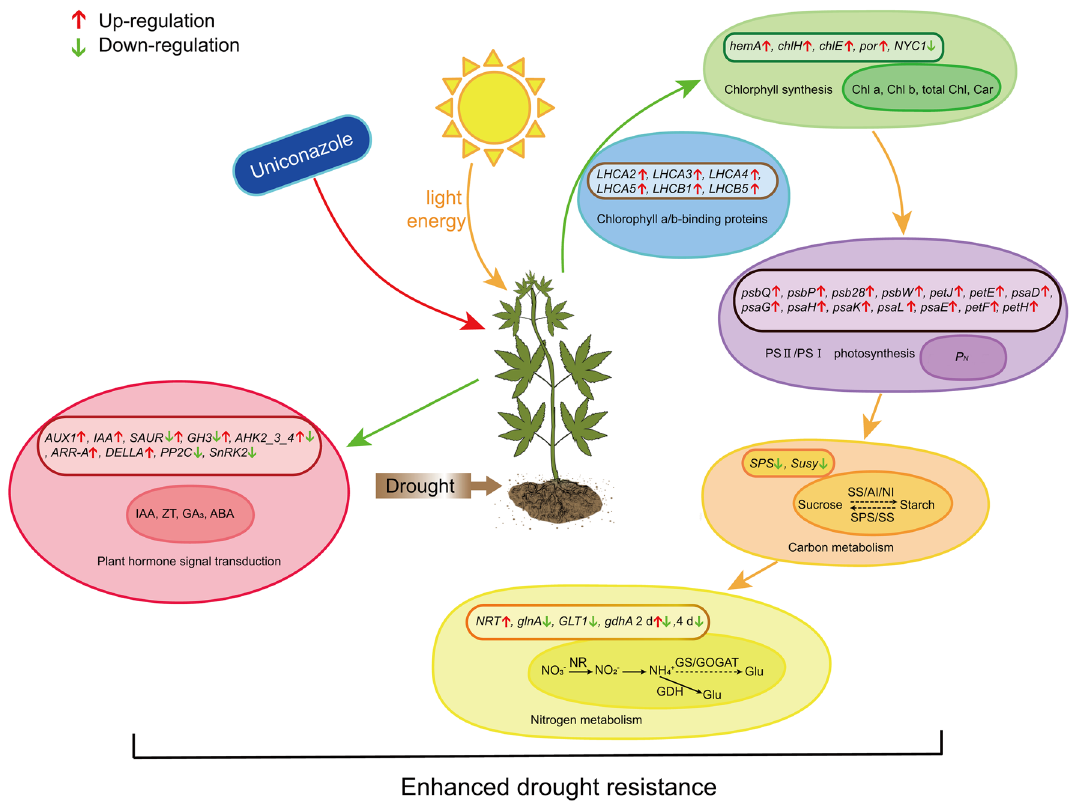
Figure 8. A hypothetical model of uniconazole on physiological and genome-wide gene expression profiling in industrial hemp seedlings under drought stress. The large ellipse indicates the whole metabolic pathway, the small ellipse represents physiological index, box means differentially expressed genes. The image was drawn by using Adobe Illustrator CC2020 (Adobe Systems Inc, San Jos, CA,